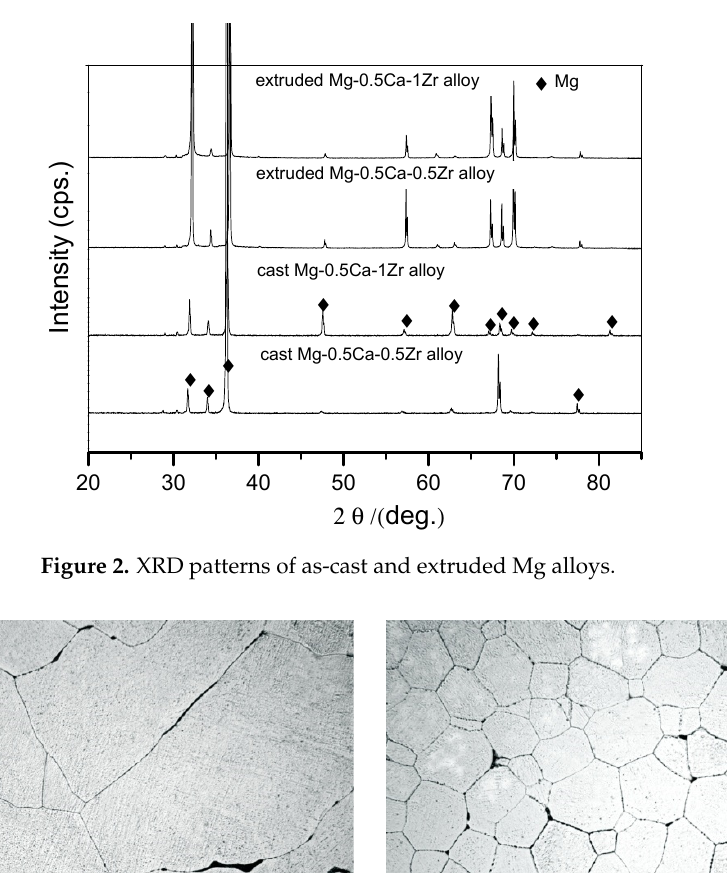
Figure 3. OM microstructure of ( a ) as-cast Mg-0.5Ca-0.5Zr alloy and ( b ) as-cast Mg-0.5Ca-1Zr alloy.